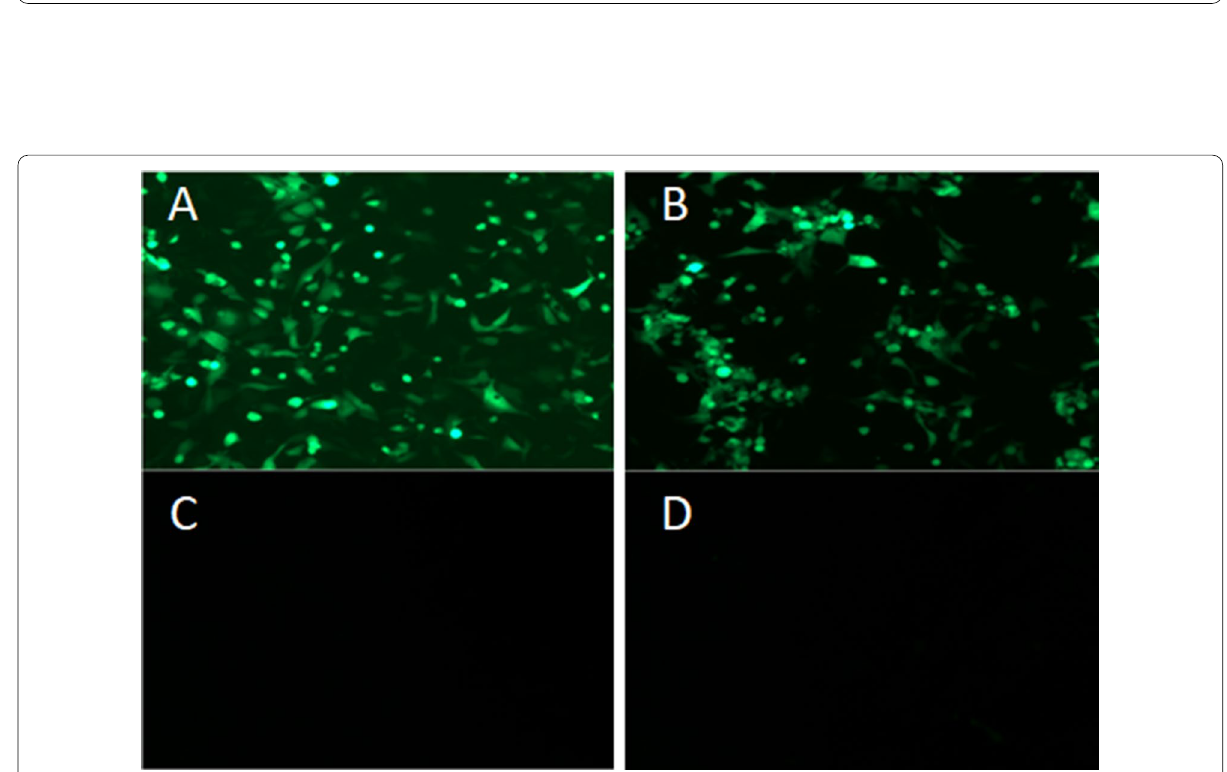
Fig. 12 Immunoaffinity purification of adenovirus. The bound viruses were eluted with 2 M, 4 M NaCl solution and PBS, and the eluent was added to the cultured HEK293A cells for reinfection. A blank and negative control group were established. After inoculation, the cells were placed at 37 °C in a 5% CO 2 incubator for 24 h to 48 h and observed and counted. A 2 M eluent group; B 4 M eluent group; C blank control group; D PBS buffer group. Green fluorescence was detected in the 2-M and 4-M NaCl solution eluent-infected cells, as shown in A and B , but we did not detect green fluorescence in PBS eluent-infected cells or non-infected cells, as shown in C and D . These results indicate that the immobilized sdAbs specifically bind to the adenoviruses and isolate them from the culture